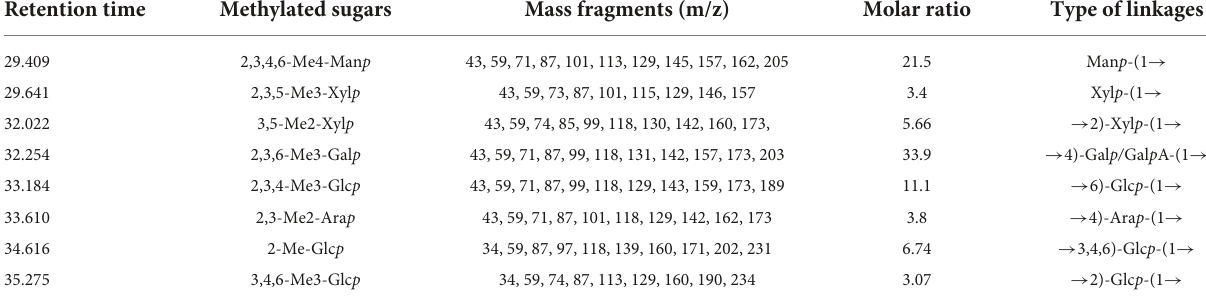
TABLE 2 Methylation analysis data for